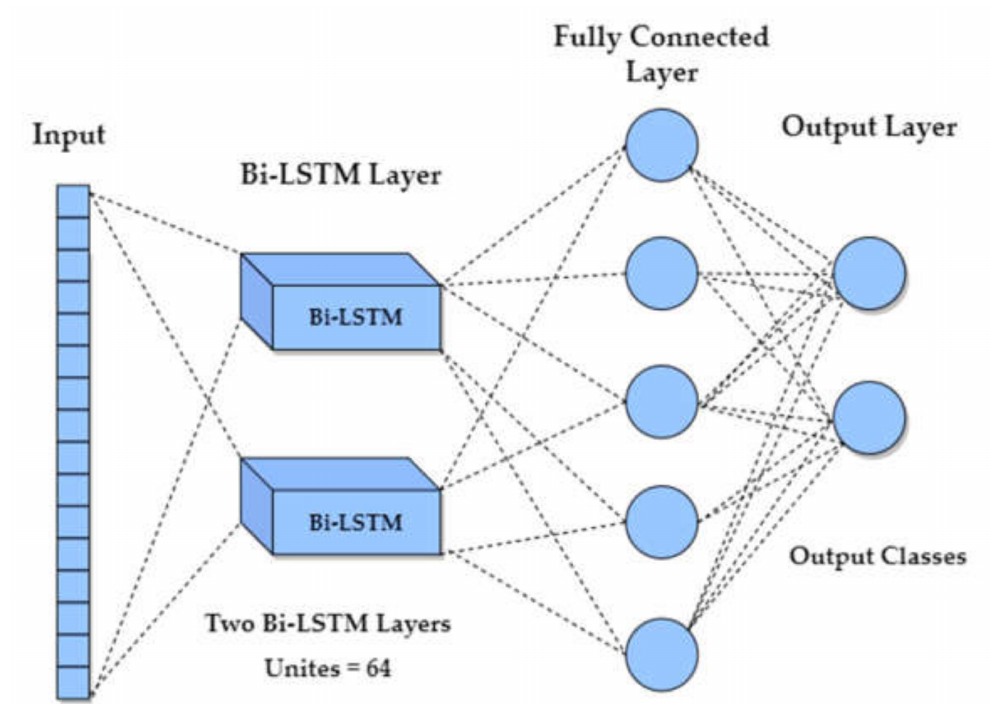
Figure 8. Bidirectional LSTM (Bi-LSTM) model with two Bi-LSTM layers with 64 units, fully con- nected layer, and output layer.